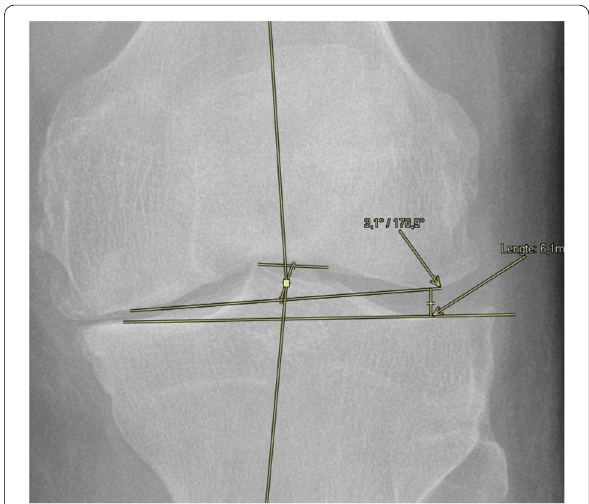
Fig. 1 The Lateral joint line opening (LJLO) is measured as the distance between the lateral tibial plateau and the lateral femoral condyle. The LJLO in this illustrative figure measures 6,1